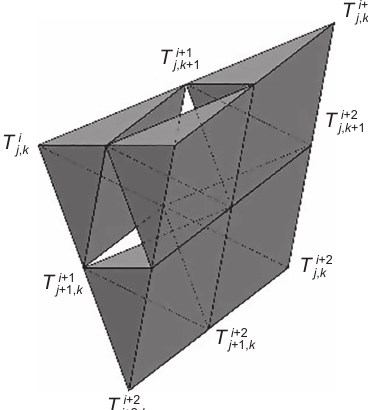
Figure 2. Comparison between quadrinomial proposed methodology, traditional binomial method and the Black – Scholes